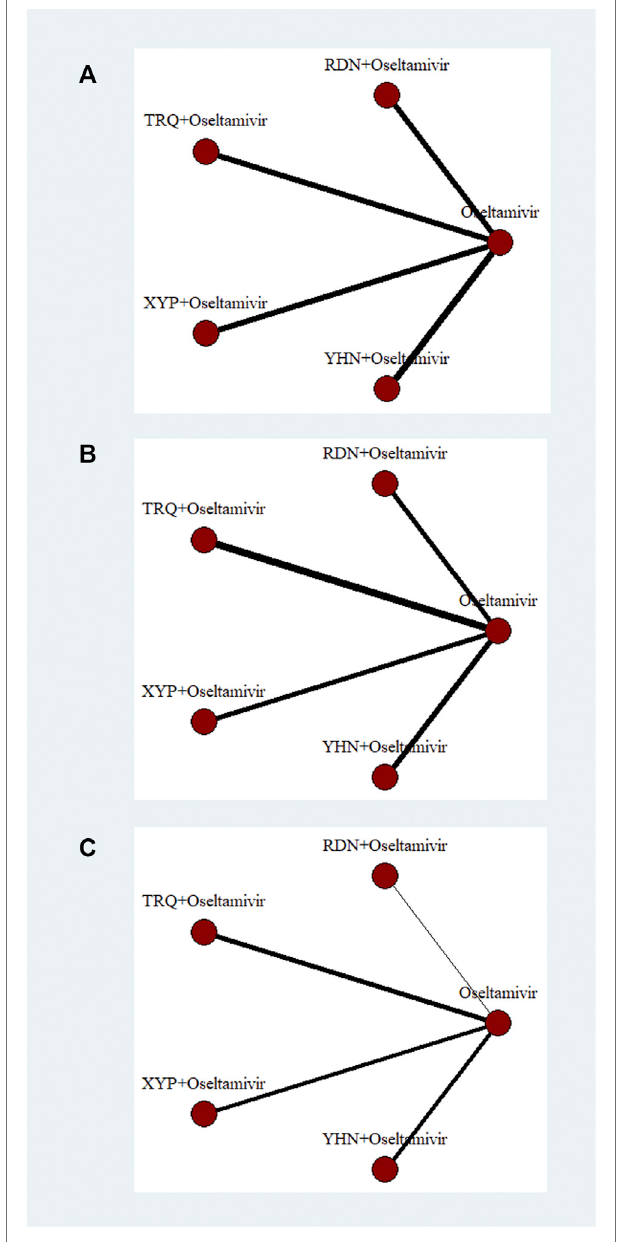
FIGURE 2 | Network plots of primary outcomes. XYP, Xiyanping; RDN, Reduning; TRQ, Tanreqing; YHN, Yanhuning. (A) Response rate; (B) disappearance time of fever; (C) disappearance time of